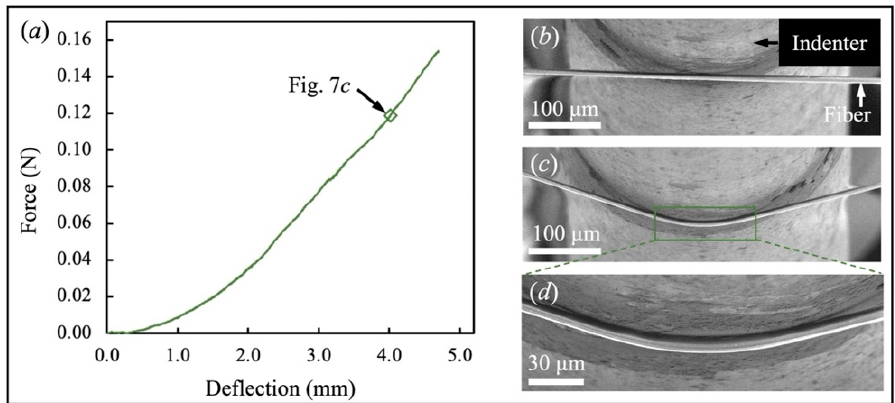
Figure 7. Failure behavior of a representative S-2 glass fiber. ( a ) Force-deflection curve; Real-time fiber morphology at S tr = ( b ) 0; ( c ) and ( d ) 4.017 mm.